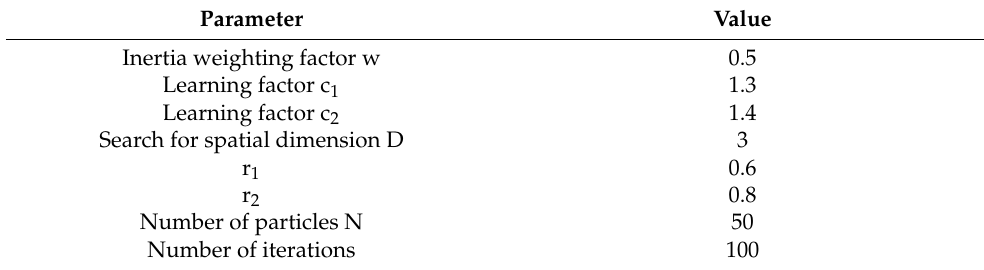
Table 3. PSO algorithm parameter